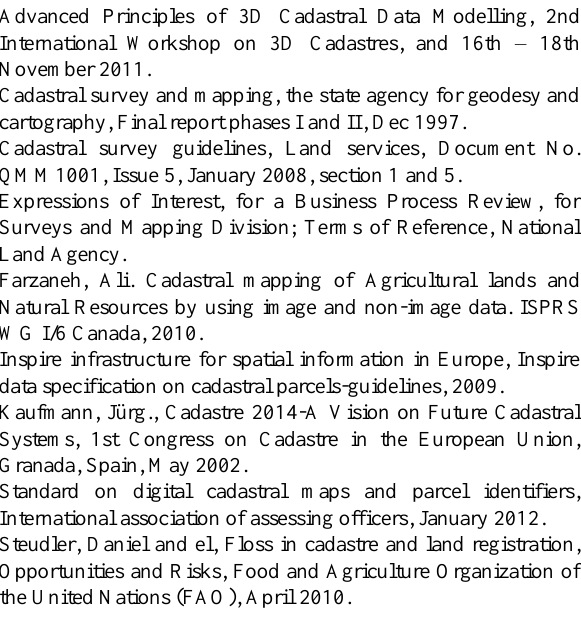
Fig 7- Final cadastre map with dwg format in AutoCad